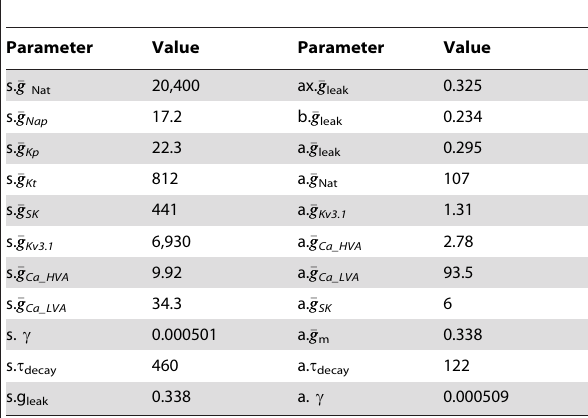
Table 3. Parameter values for the dually-constrained model shown in Figure 4.